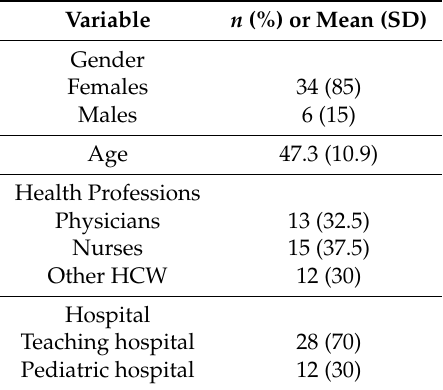
Table 1. Participants’ characteristics.